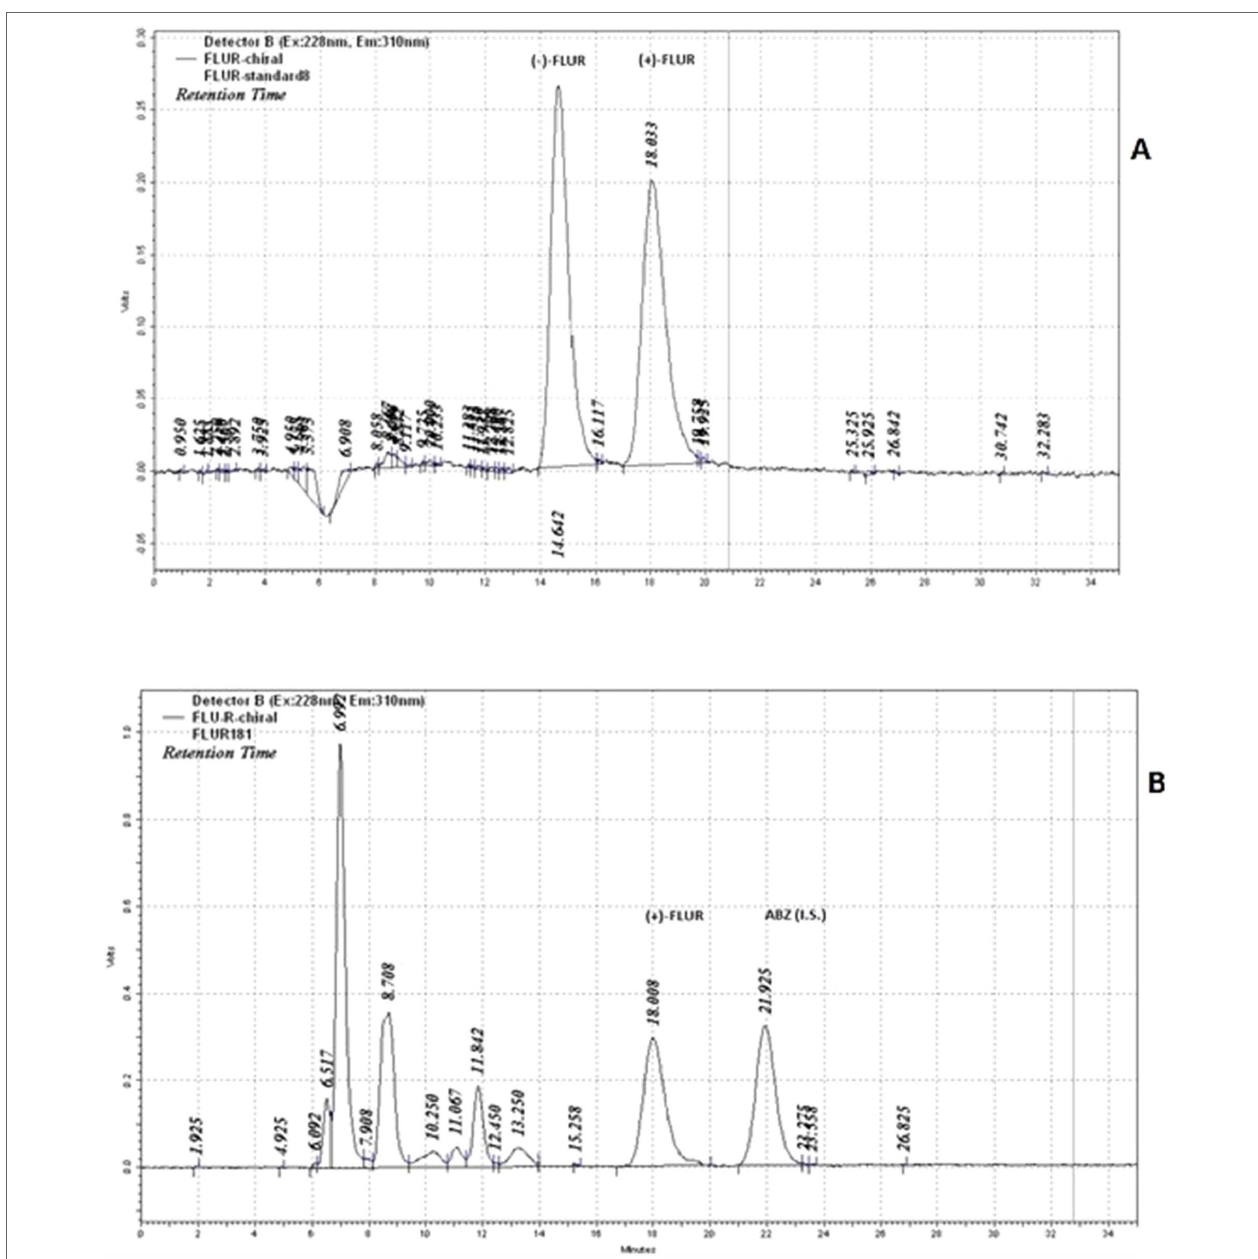
FIGURE 2 | Chiral chromatograms of standard of FLUR enantiomers (A) , and incubation sample (B) (pooled human liver cytosol incubated with 10 µM FLU). Retention times of the individual compounds: t R = 14.6 min for (−)-FLUR enantiomer; t R = 18.0 min for (+)-FLUR enantiomer; t R = 21.9 min for I.S. albendazole